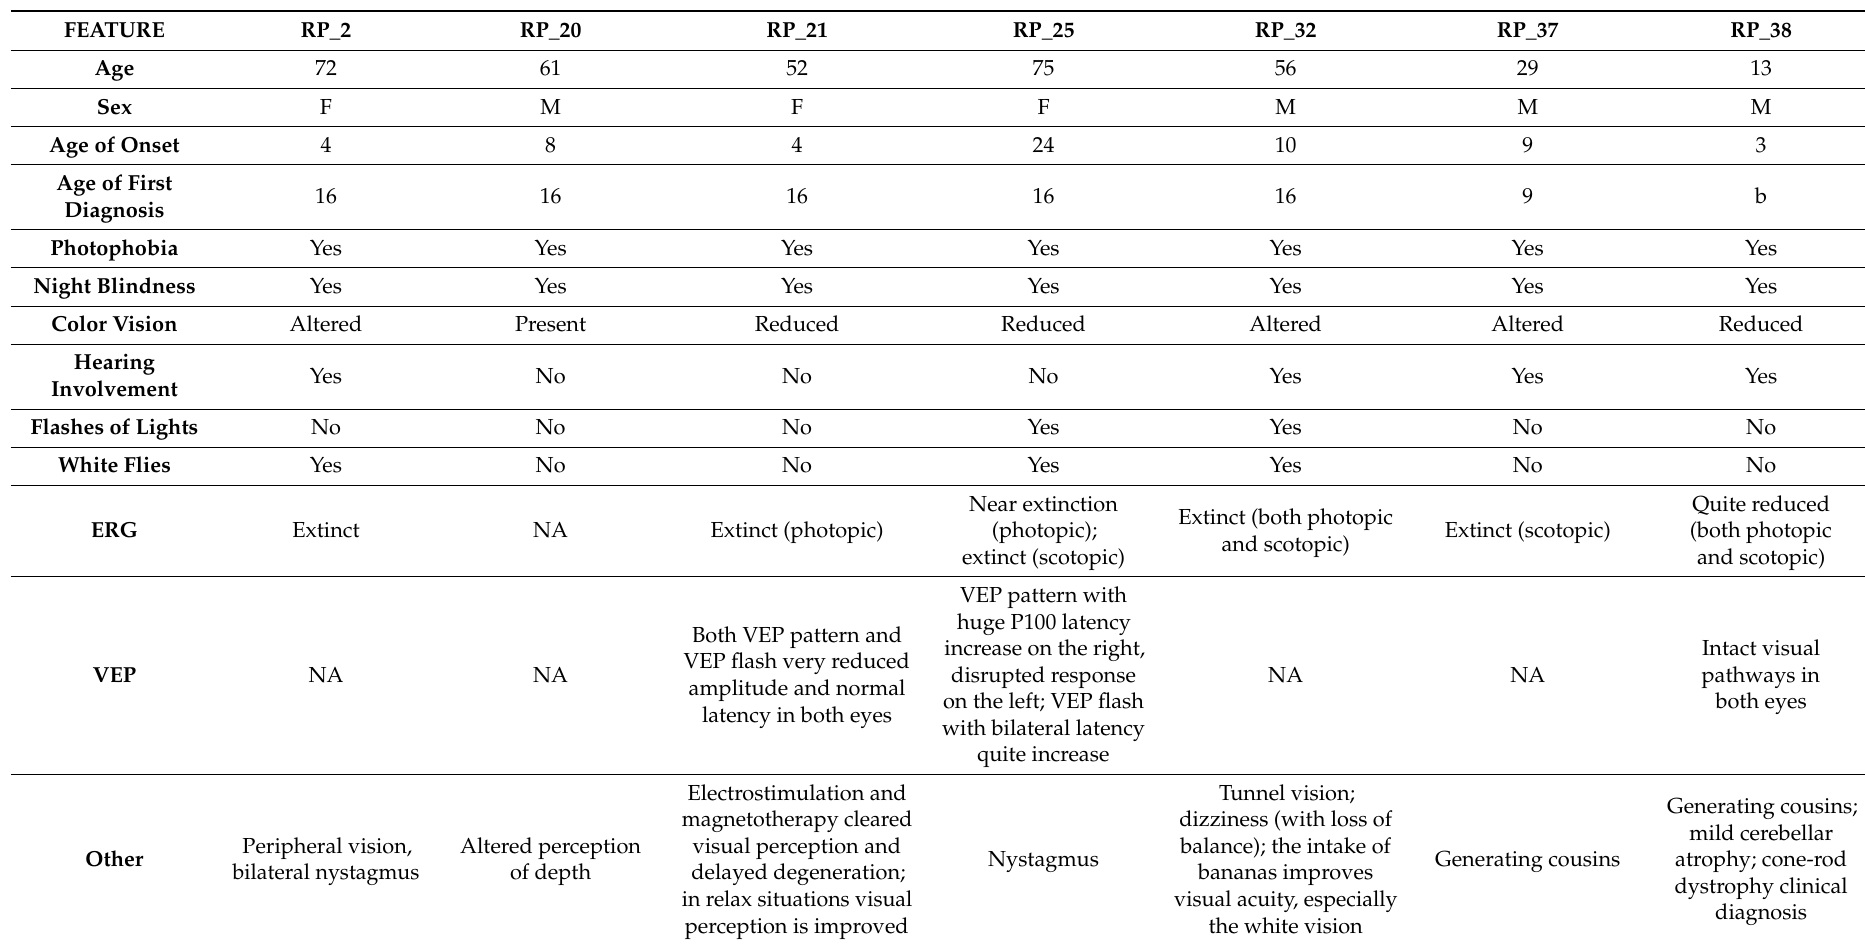
Table 1. Clinical features of the seven probands of the reported Sicilian and Egyptian families. Reported signs, symptoms and clinical-pathological features consisted of those most frequently observed in retinal dystrophies, even if several are characteristics of phenotypically orphan